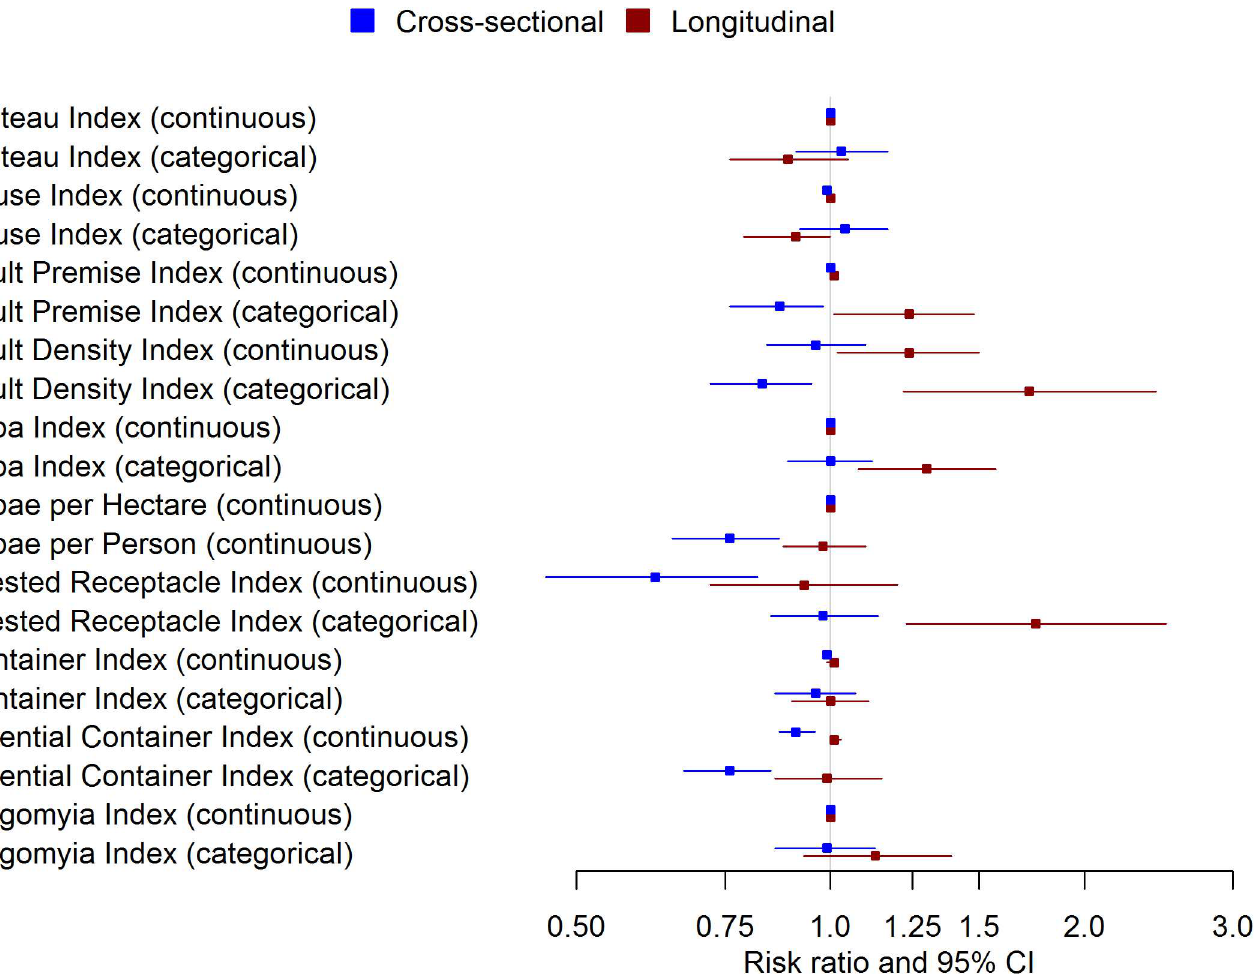
Fig 4. Forest plot of block-level indicators of Ae . aegypti abundance. In Figure 4, the adjustedrisk ratio and 95% CI for block-level indicators of vector density for the cross-sectional and longitudinalscenariosare